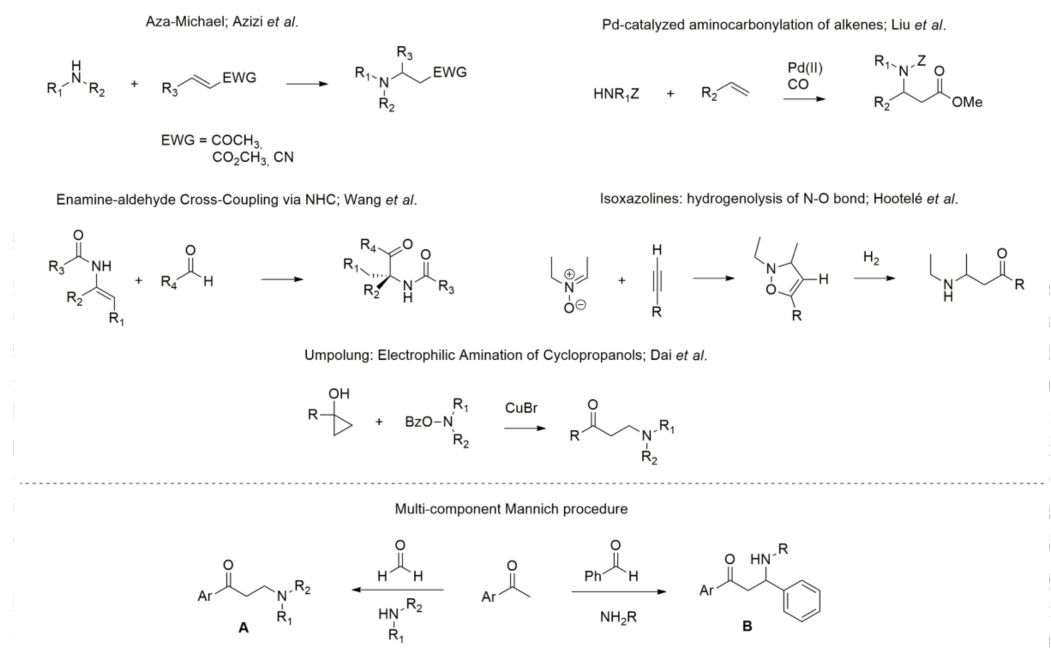
Figure 2. Alternative synthetic routes for accessing β -amino carbonyl